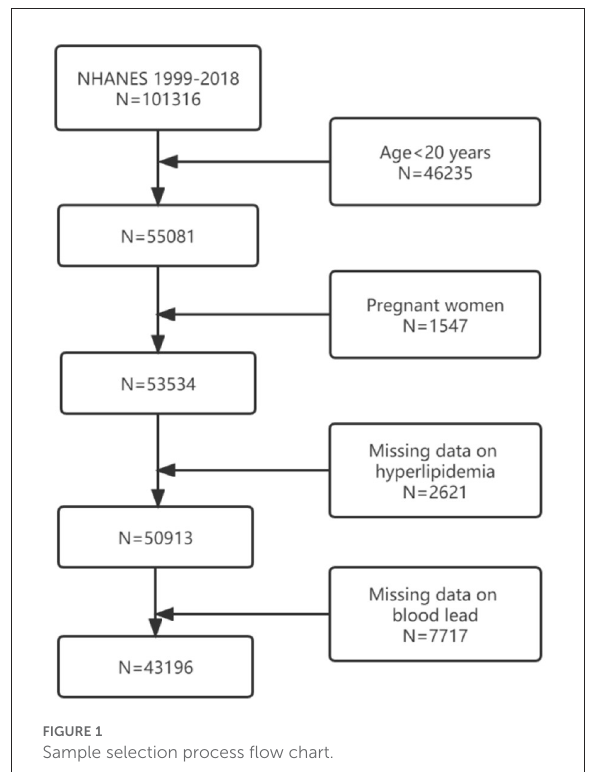
FIGURE1 Sample selection process flow